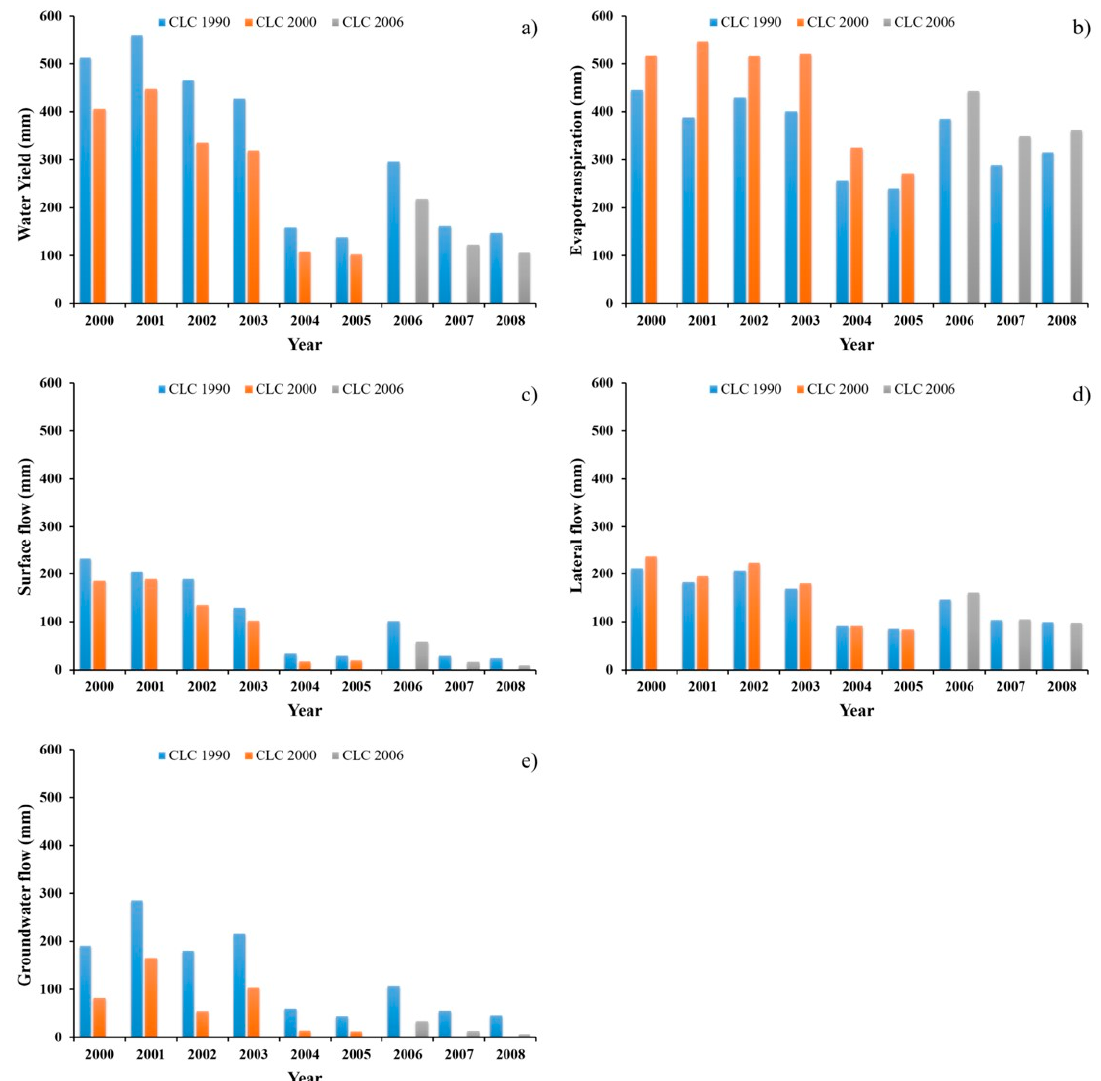
Figure 9. Quantity of water (mm) ( a ) in the water yield; ( b ) evapotranspiration; ( c ) surface flow; ( d ) lateral flow; and ( e ) groundwater flow. The blue bars are the reference model (simulated between 2000 and 2008 with the CLC 1990), the orange bars are the CLC 2000 model (simulated between 2000 and 2005), and the grey bars are the CLC 2006 model (simulated between 2006 and 2008).